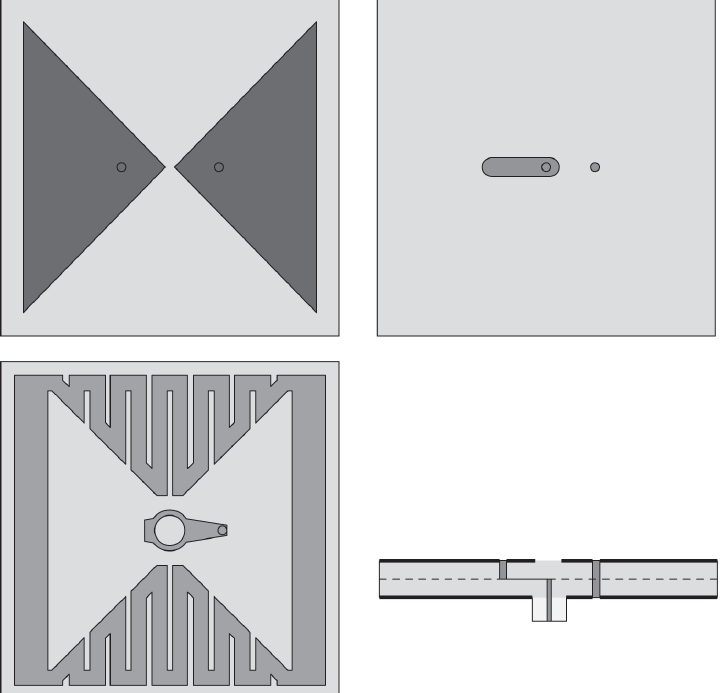
Figure 30. Design of the double-layer bowtie antenna (redrawn from [117]). Dark gray top metal face, medium gray center metal face, and light gray dielectric